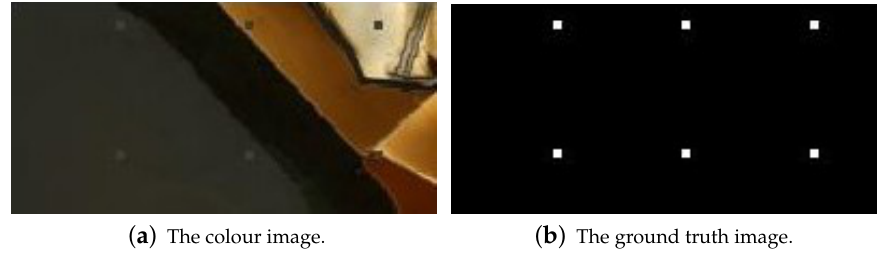
Figure 2. The colour image and the ground truth image of Sanjose data set.